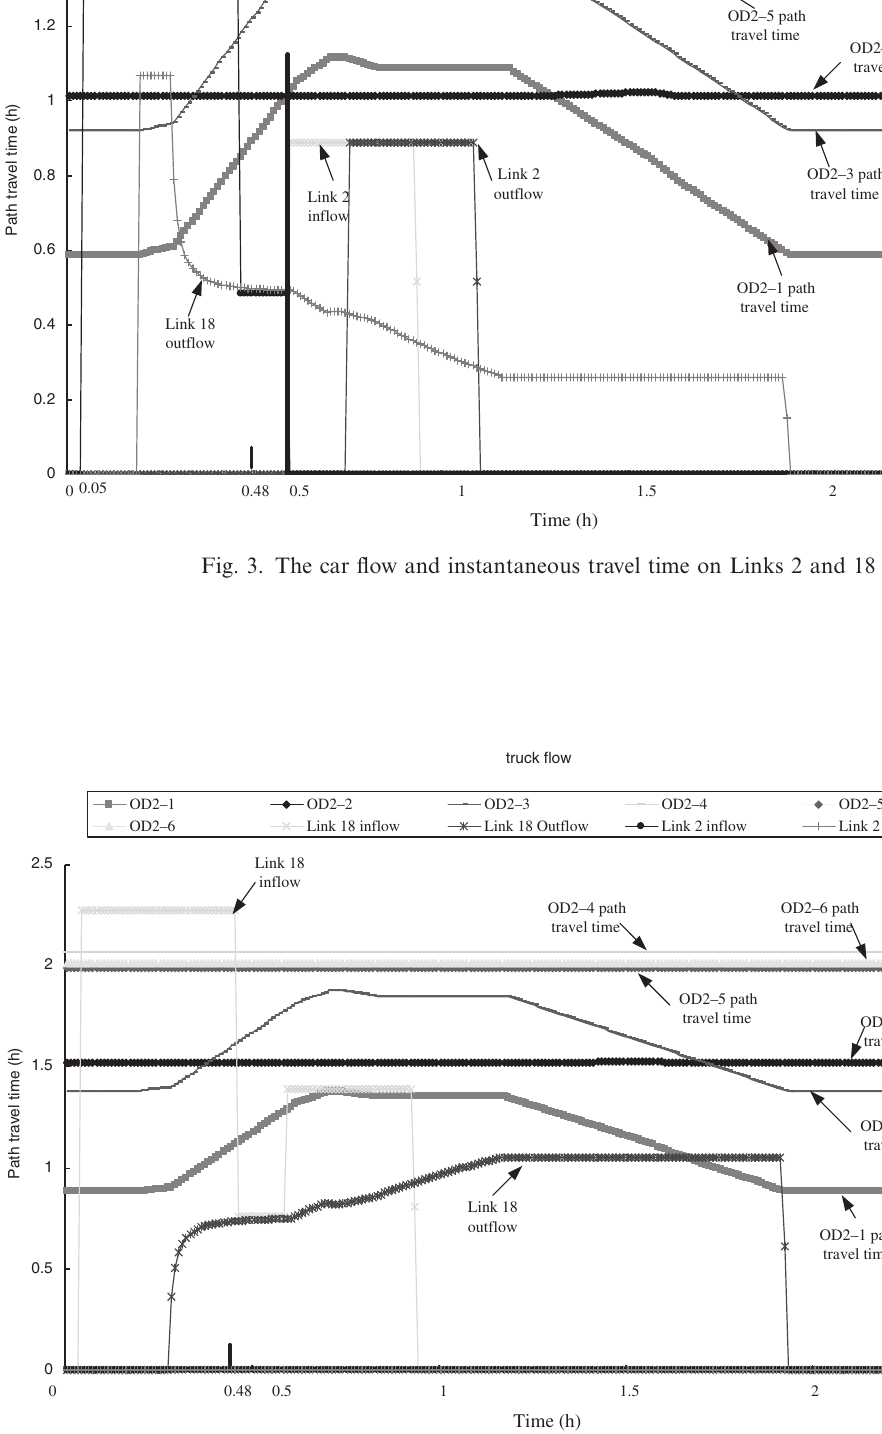
Fig. 4. The truck flow and instantaneous travel time on Links 2 and